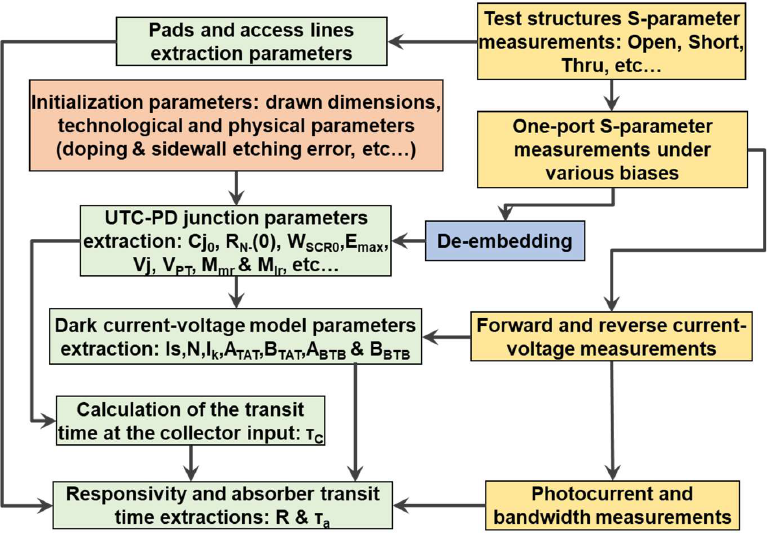
Figure 3. Methodology flow of the measurements and the parameter extraction of the UTC-PD.